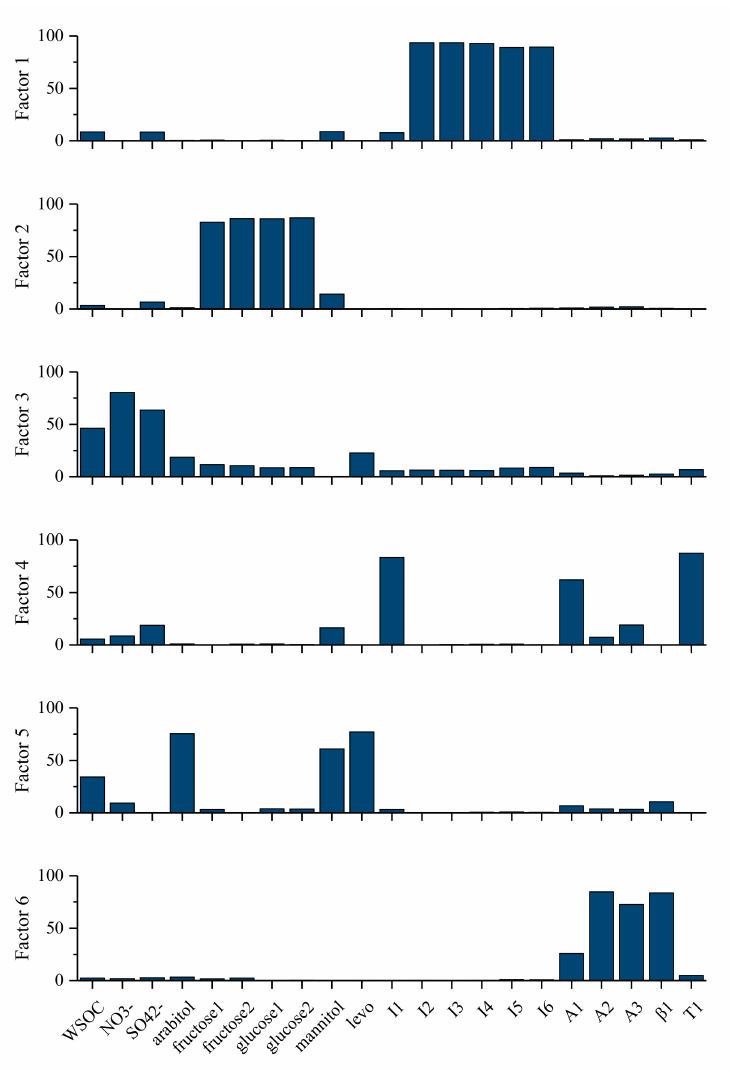
Figure 3. PMF source profile (% of species) of WSOC in PM 2.5 in Bengbu. Based on the high-loading species in each factor, factors 1–6 were identified as SOAs from isoprene, WSOC from soil [47], SOAs associated with secondary inorganic ions, SOAs from toluene, WSOC from biomass burning, and SOAs from terpenes, respectively. Among them, WSOC in F2 and F5 should be primary in nature, while WSOC associated with F1, F3, F4, and F6 were secondary, and the sum of the WSOC concentrations in these sources was regarded as SOC PMF-based . It should be noted that MGA (I1) and HGA (A1) also had high loadings in factor 4, in addition to DHOPA (T1). So in addition to toluene SOAs, there may be some contribution of isoprene SOAs and monoterpene SOAs in F4. Analysis showed that T1, I1, and A1 are significantly correlated with each other (r > 0.6), suggesting that the emission pattern or oxidation pathway of their precursors is similar. Therefore, it was not surprising to find them in the same factor in PMF analysis. A different number of factors was tried in PMF analysis, but we failed to separate them. Factor 3 was characterized by the high weight of nitrate and sulfate, WSOC also had a high weight, while the weight of the SOA tracers was small, indicating that a large part of SOC might be formed in a similar way with sulfate and nitrate but different from that of the measured SOA